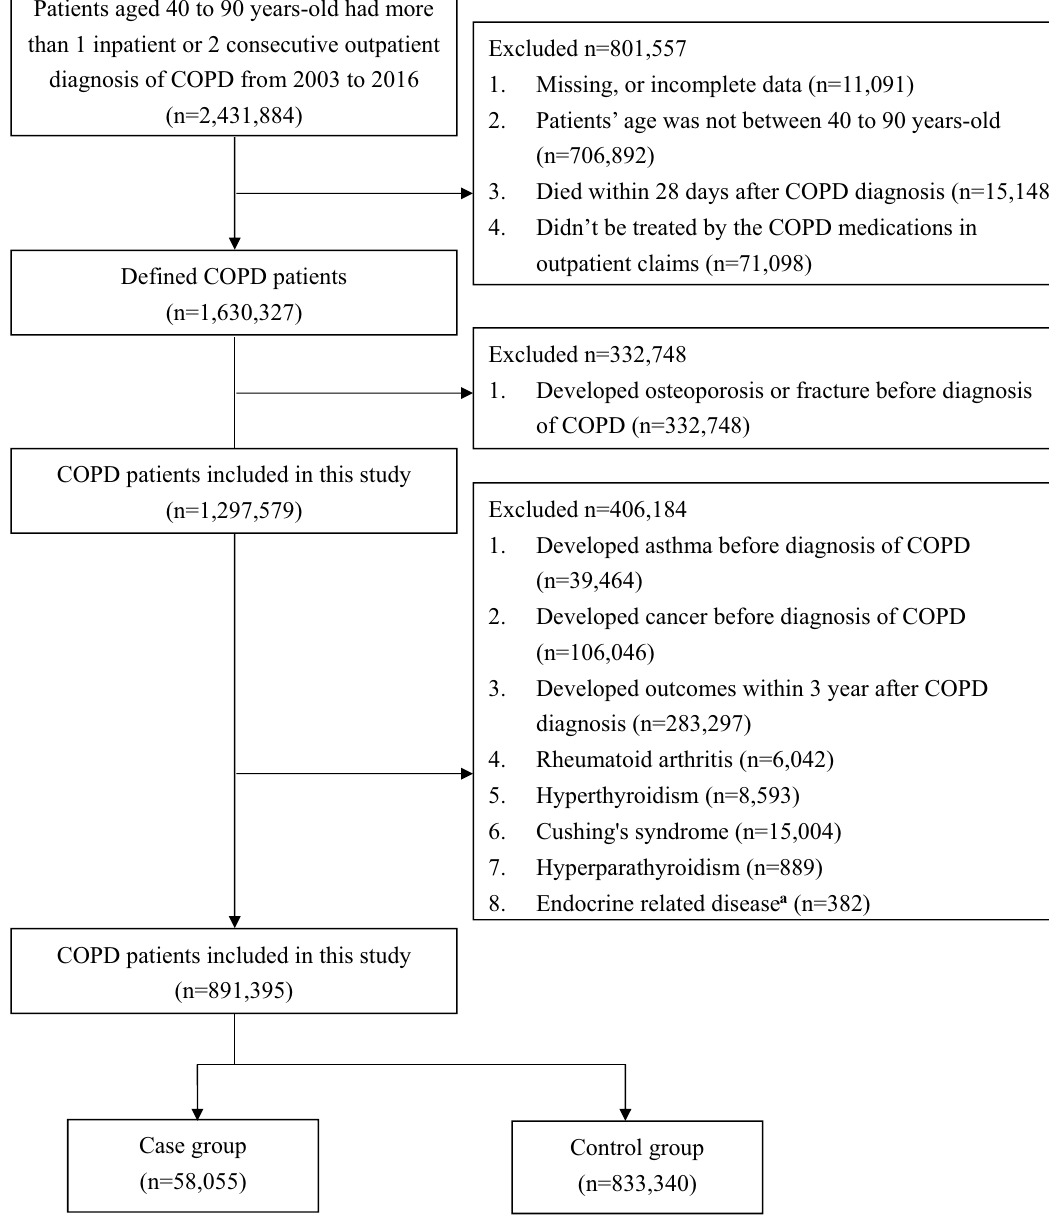
Figure 1. Study flow diagram of study cohort selection. Endocrine related disease: growth hormone deficiency, hypogonadism, hypophosphatasia, and